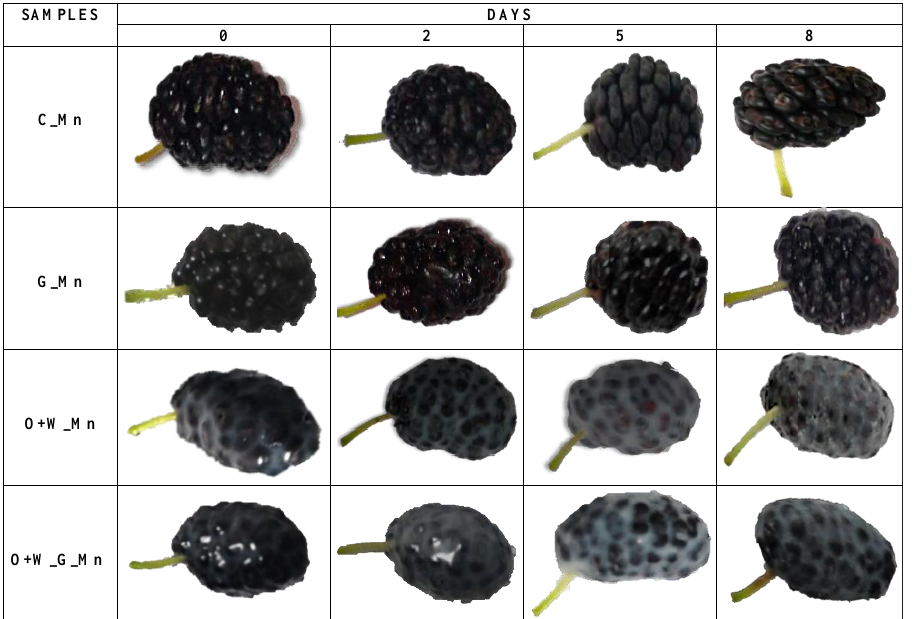
Figure 9. Appearances of the treated (G_Mn; O+W_Mn; O+W_G_Mn) and untreated (C_Mn) mul- berry fruits throughout the storage period (8 days) at 4 °C.